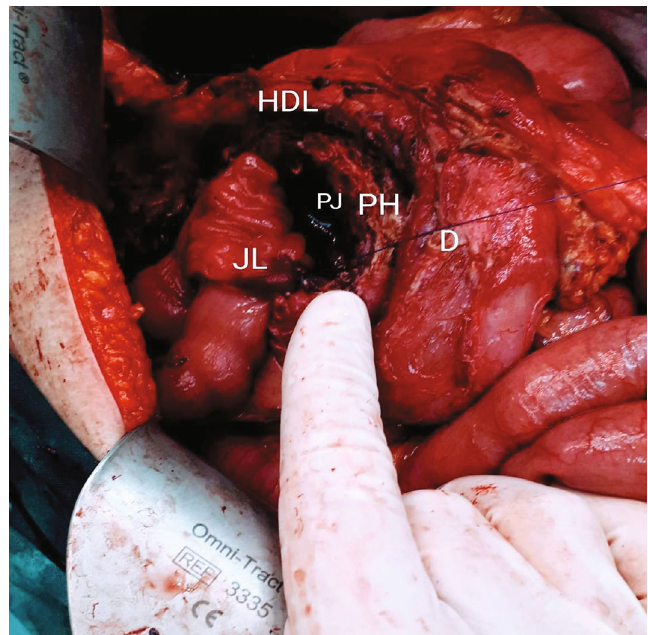
Figure 5: Intraoperative view of the performed Roux-en-Y pancreaticojejunostomy (on the pancreatic head defect) (JL: jejunal loop; PH: pancreatic head; D: duodenum; PJ: pancreaticojejunostomy; HDL: hepatoduodenal